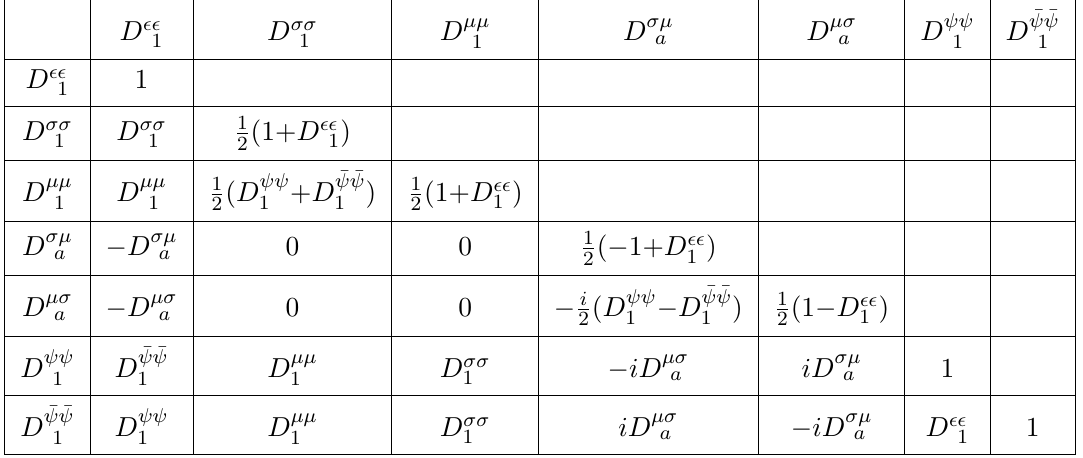
Table 7 . The defect classifying algebra for the fermionic Ising